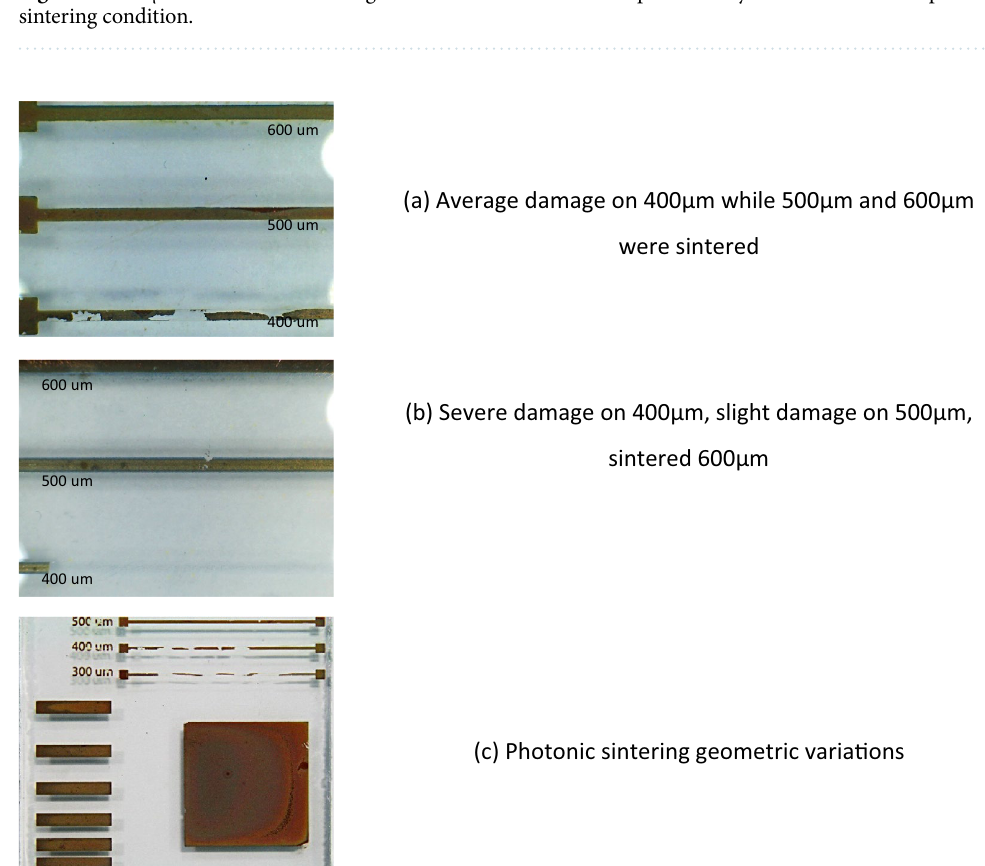
Figure 6. The impact on feature size on the sintering conditions for the 100 N